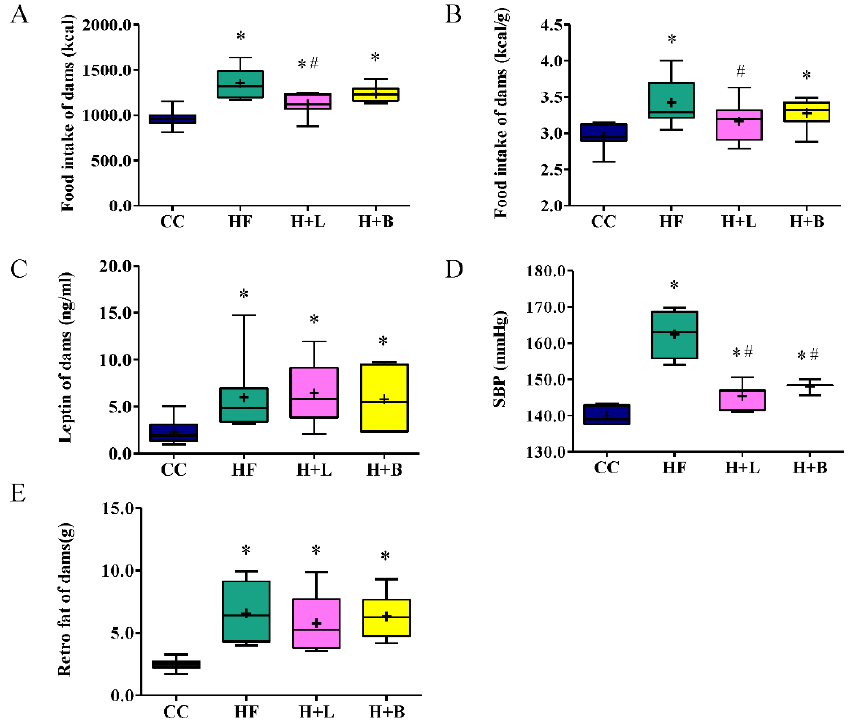
Figure 2. Metabolic profiles of the dams before delivery. ( A ) The total calorie intake of dams during the study period; ( B ) caloric intake per unit of BW; ( C ) plasma leptin level of dams; ( D ) systolic blood pressure of dams before delivery; ( E ) weight of retroperitoneal fat deposits. Data are shown as a box and whisker plot. The box is bounded on the top by the third quartile, and on the bottom by the first quartile. The median divides the box. The diagram also shows the mean level (cross symbol) “+”. The whiskers are the two lines outside the box. One extends upward from the third quartile (Q3) to the maximum, and the other goes downward from the first quartile (Q1) to the minimum. Data falling outside the Q1 to Q3 range are plotted as outliers of the data. * Compared to the CC group, p < 0.05; # compared to the HF group, p < 0.05. SBP, systolic blood pressure; retro, retroperitoneal.